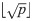
Error rate estimates for simulation studies with many predictors with effect and n = 20.Shown are different error rate estimates for an additional simulation study with two response classes of equal size and many predictor variables with effect. The error rate was estimated through the test error, the OOB error, the stratified OOB error, the CV error, and the stratified CV error for settings with sample size n = 20 and different numbers of predictors, p. The mean error rate over 500 repetitions was obtained for a range of mtry values. The vertical grey dashed line in each plot indicates the most commonly used default choice for mtry in classification tasks, that is ⌊p⌋.